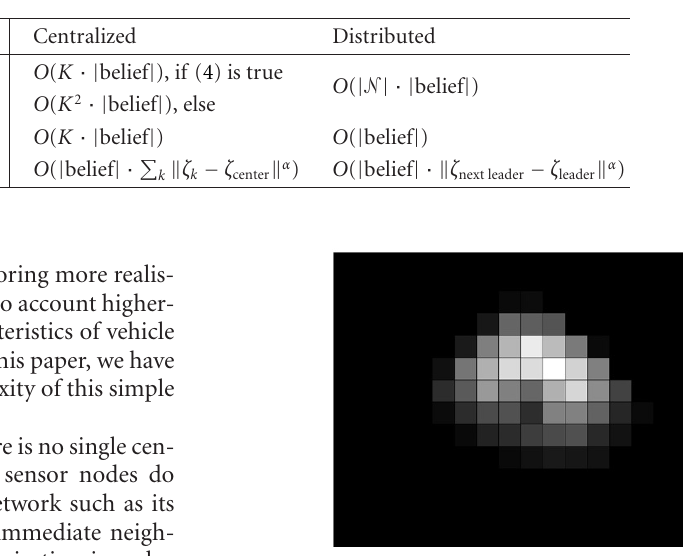
Table 1: Single-step cost for centralized and distributed Bayesian tracking. In the second row, (cid:2) is the leader’s neighbor list. The last row is the power needed to communicate reliably through radio. We assume a particular model where the communication power is adjustable and is proportional to the communication distance raised to the power of RF attenuation exponent α ( α ≥ 2). RF overhead consumption and power consumption of sensing and is neglected.